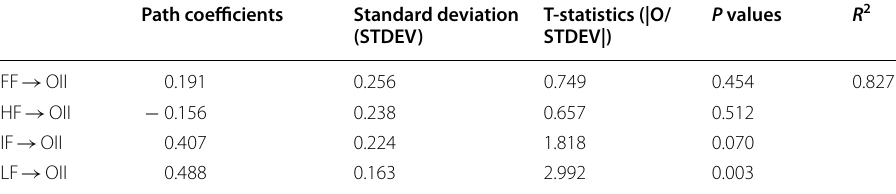
Table 6 Assessing the results of inner